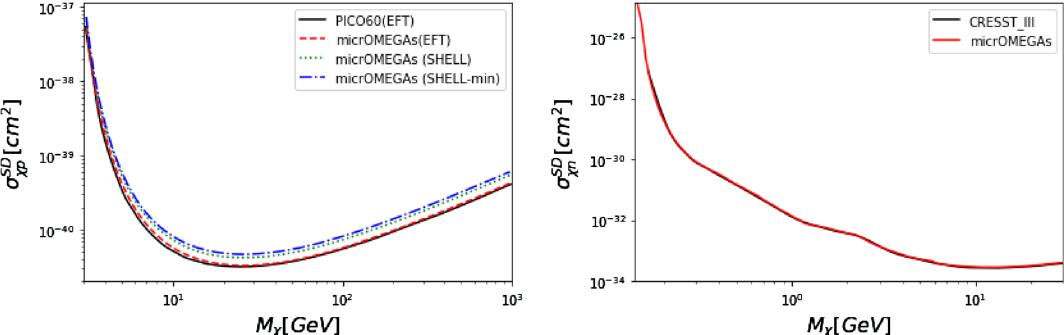
Fig. 7 Left: comparison of the recasted 90% limit on σ SD χ p from micrOMEGAs (red) with the PICO-60 limit [4,5] (black) using the EFT form factors from Ref. [39]. The impact of the choice of form factor is illustrated for the SHELL (green-dot) and SHELL-min